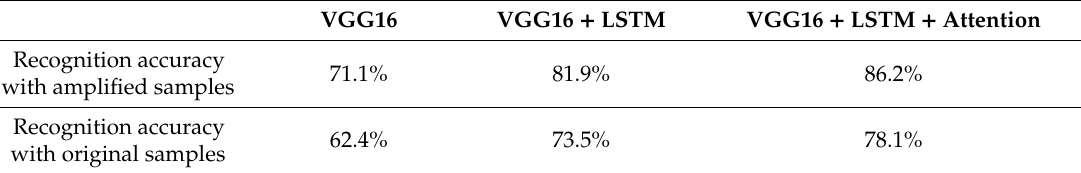
Table 1. Comparison of VGG16, VGG16 + LSTM, and VGG16 + LSTM + Attention.